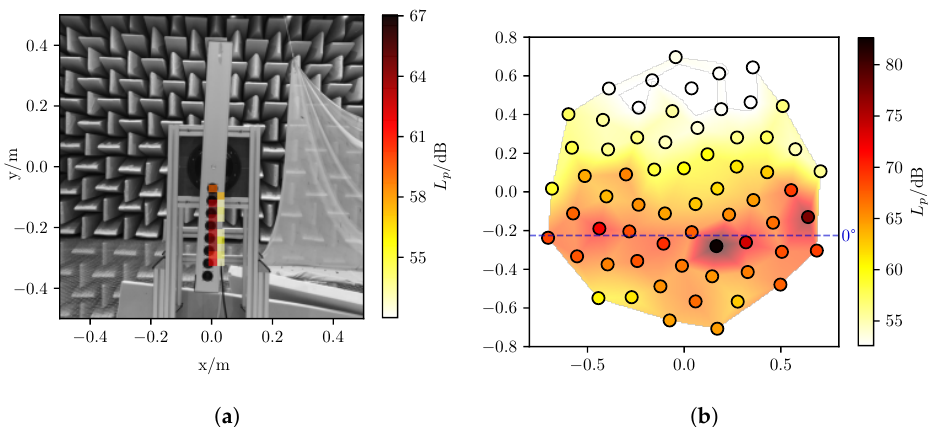
Figure 4. Test case 1 with a standing speaker array and no signal delay between the speakers: ( a ) source distribution; ( b ) source directivity in the direction of the microphones at the 5 kHz octave band. The blue dotted line indicates the theoretical maximum at 0 ◦ .